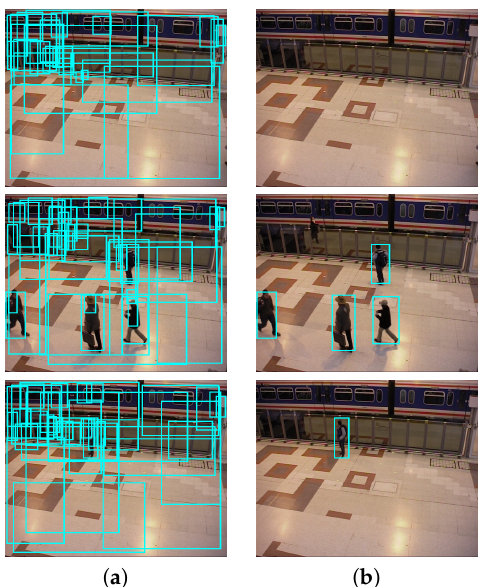
Figure 4. Multiple thresholding examples with Faster R-CNN detector [1]. Three examples (rows) are shown where columns are obtained bounding boxes for thresholds ( a ) ˜ τ 1 (cid:110) (cid:111) j = L = 60 ˜ τ j n the full set j = 1